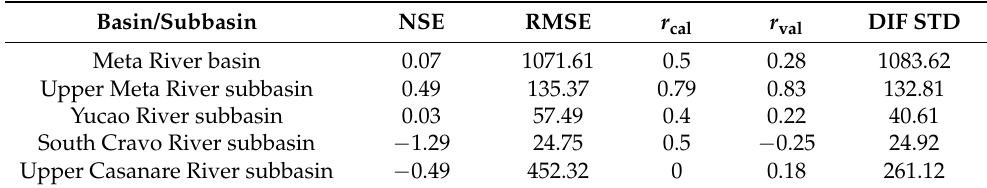
Table 5. Metrics for the model performance in the studied subbasin during calibration and validation periods using the InVEST–AWY model.